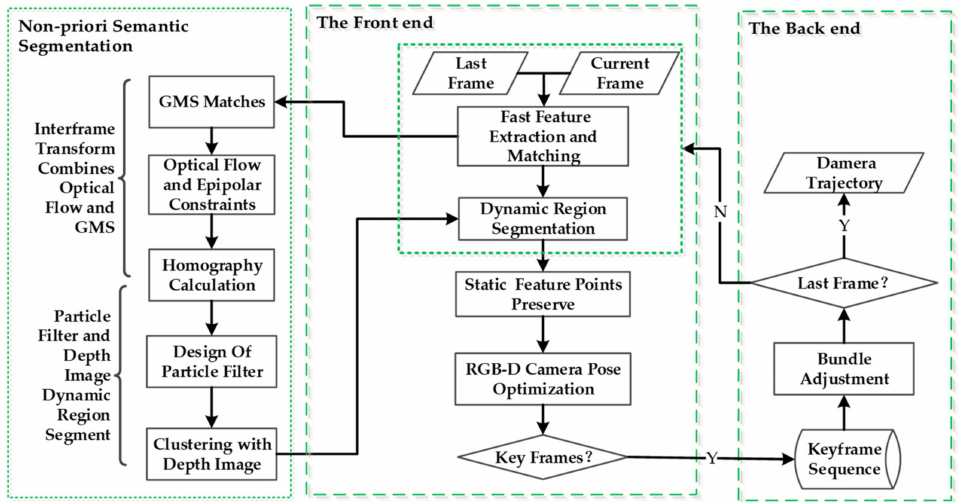
Figure 1. The overall flow chart of